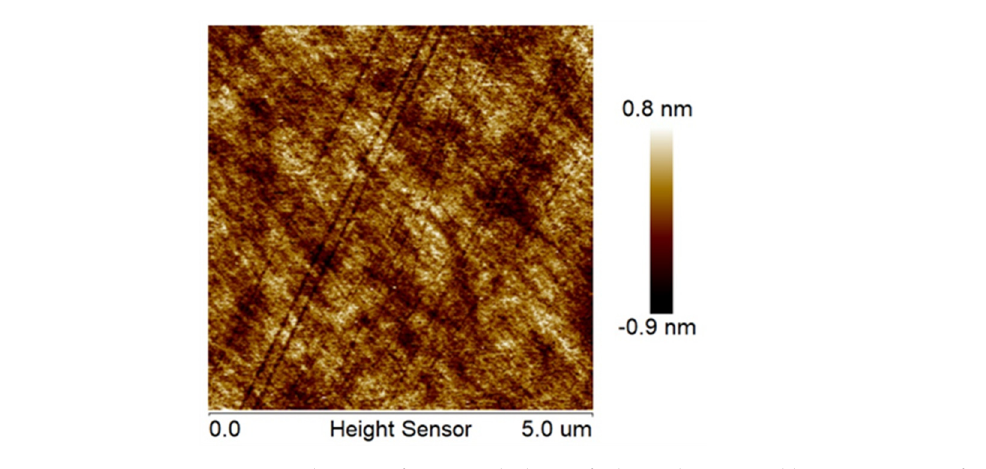
Figure 3. Silicon surface morphology of silicon determined by using atomic force microscopy after CMP. Isotropic scratches and textures can be clearly observed with an RMS roughness of 0.247 nm within a 5 × 5 μ m 2 area.